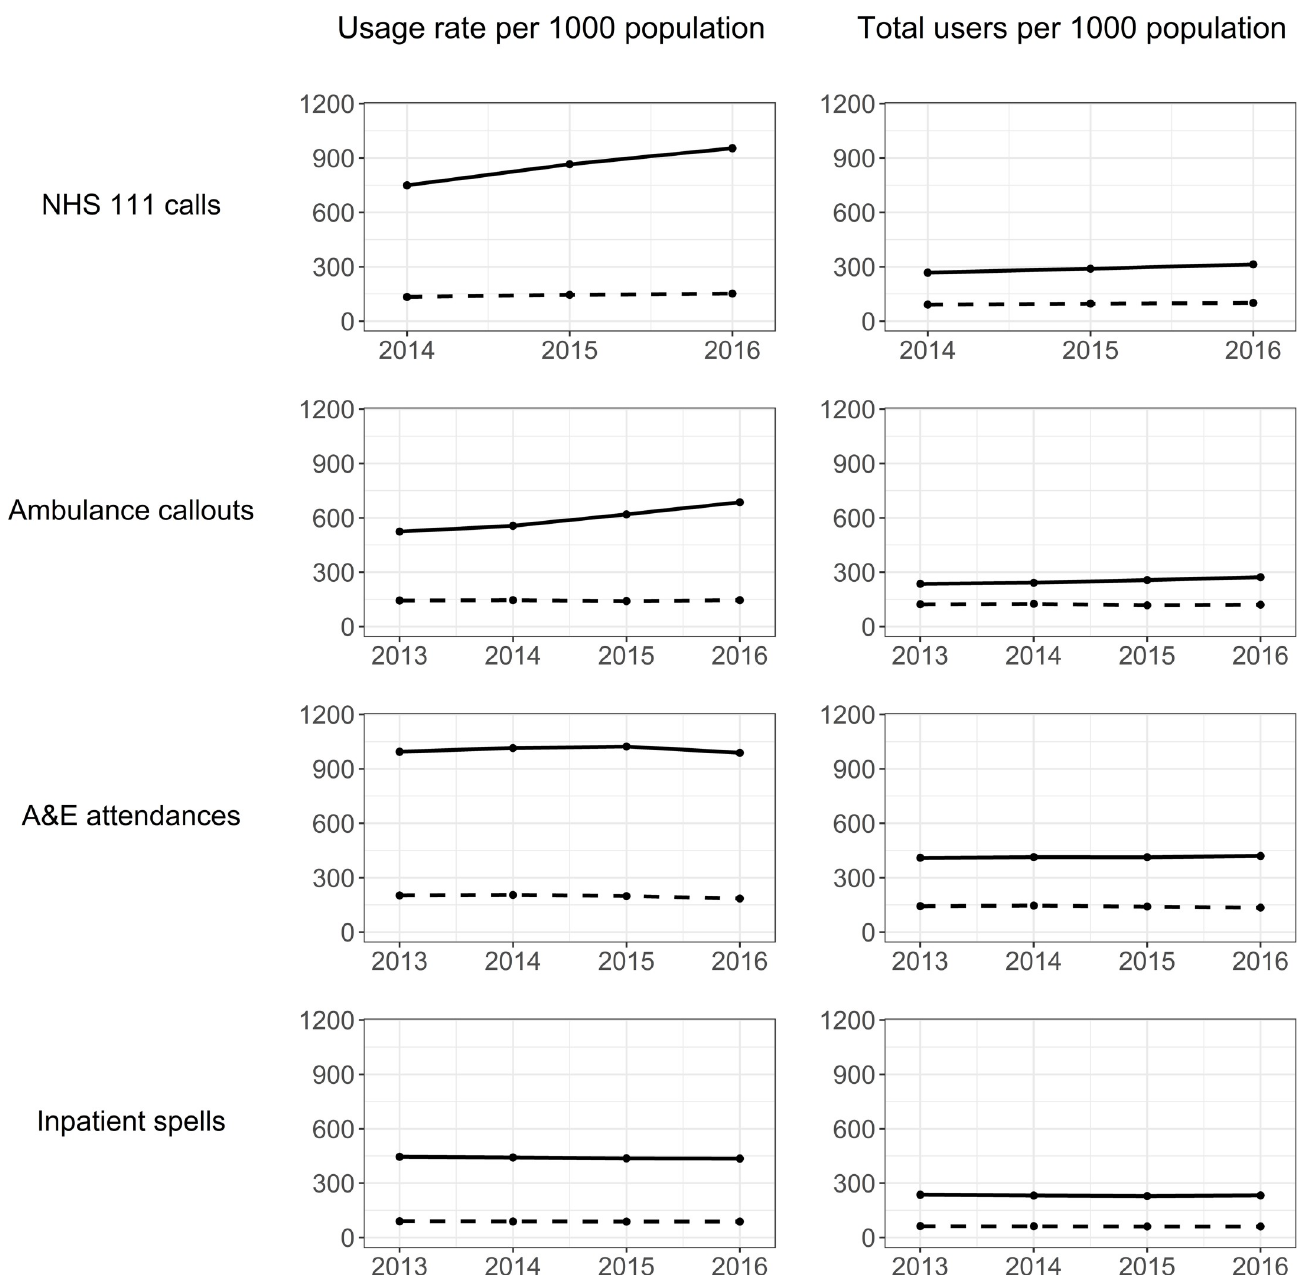
Fig 2. Age & sex standardised usage rates and total users for the UMHS cohort (solid lines) and UEC-only group (dashed lines), per 1000 population for each UEC service by study